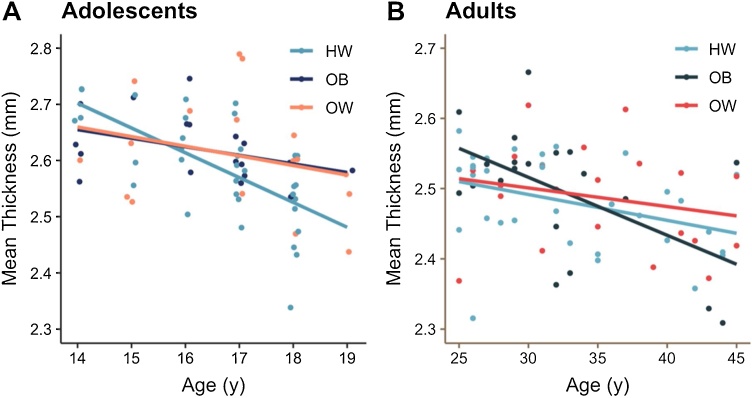
Combined effects of age and BMI-measures on global cortical thickness.A) Excess-weight adolescents show increased global CT between ages 14 and 19 relative to lean adolescents. X-axis values were jittered for improved visualisation. B) Increasing age and BMI are related to decreased global CT in adults. Data have been plotted by weight group for improved visualisation.